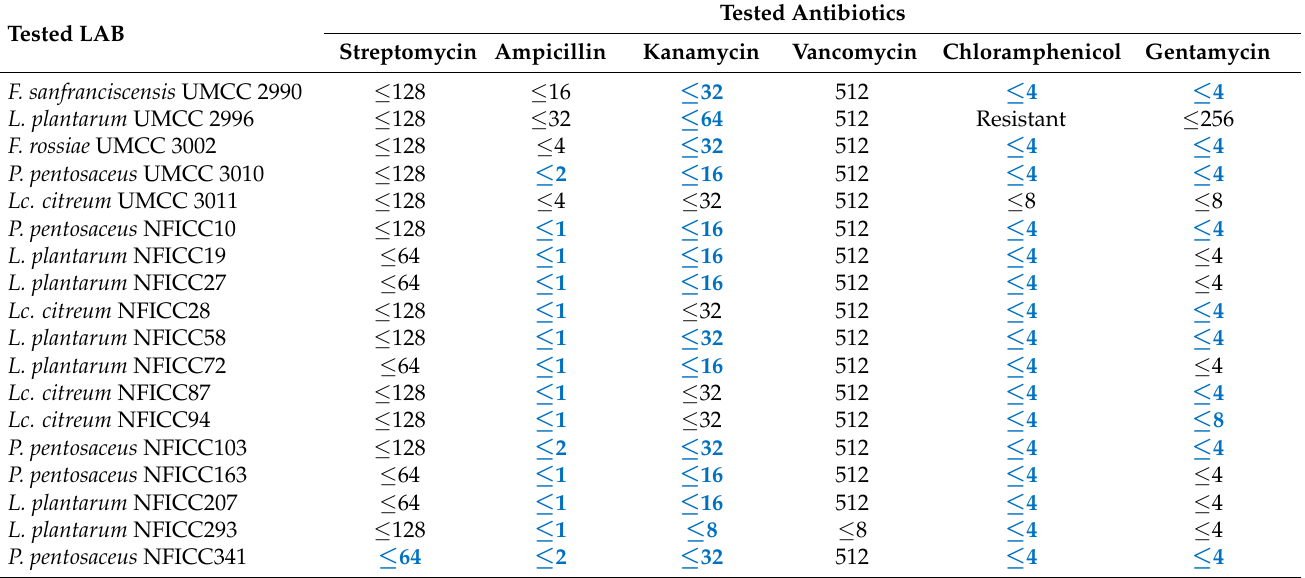
Table 6. Minimum inhibitory concentration (MIC) ( µ g/mL) of the antibiotic susceptibility of the selected LAB. The values reported in bold and blue color are under or equal to recommended EFSA cut-offs and underline the susceptibility of the strains.